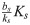
Contour plot of activated regulator concentration ra = r4 = [R2S2] around the time of ignition as a function of time and distance from the center of the colony.The plot contains the exact solution of the system of equations presented in Eqs (2)–(5) as well as Eq (8), i. e. the system describing total signal molecule concentration. The concentration necessary for ignition (bsksKs in the static case) is marked by the red contour. A logarithmic colour-scheme has been chosen due to the large range of values pre- and post-ignition.